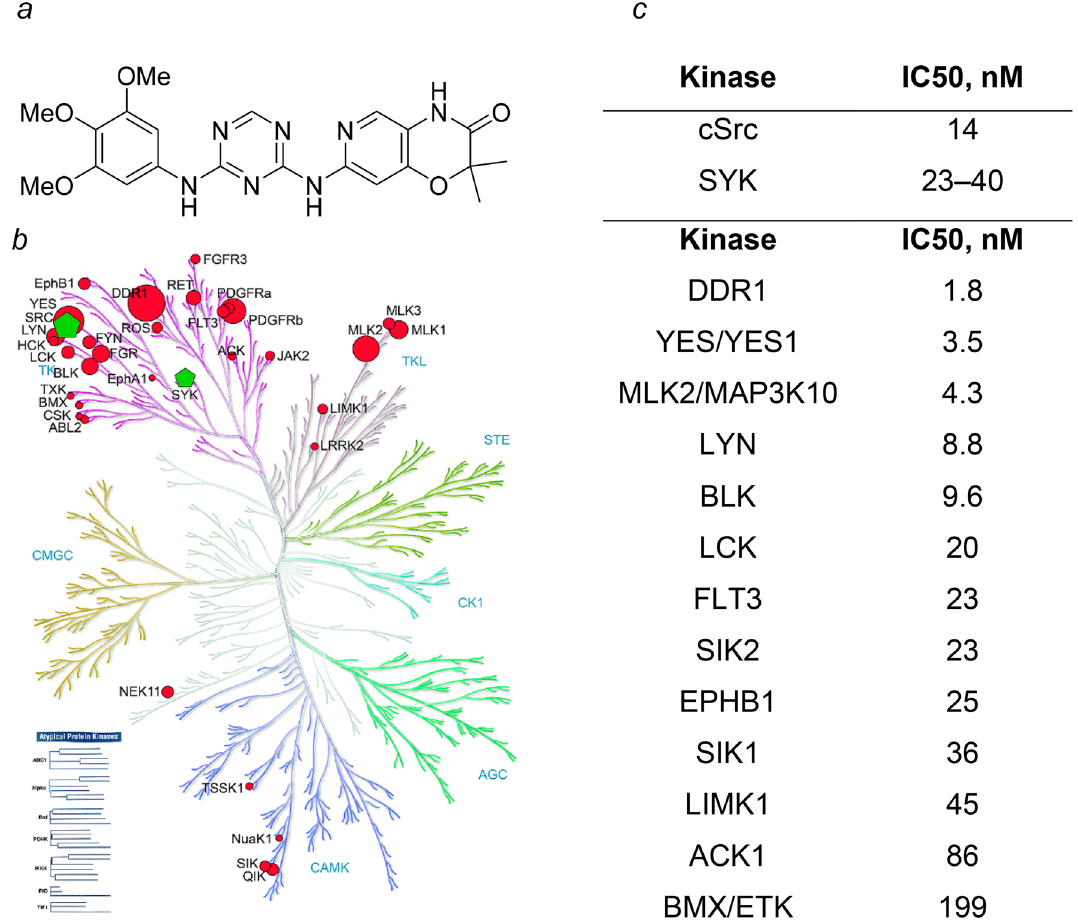
Figure 1. ( a ) Chemical structure of MT-SYK-03. ( b ) Kinase profiling of MT-SYK-03 (500 nM) against 343 kinases. Circle size on dendrogram is proportional to percentage of kinase residual activity: big circles, < 10% activity; small circles, < 20% activity. Green pentagons represent SYK and cSrc kinases. Kinase dendrogram background taken from Manning et al. Science 298 (2002). Reprinted with permission from AAAS. ( c ) IC 50 values for cSrc and SYK kinases and other kinases with residual activity at 500 nM MT-SYK-03 below 20%.